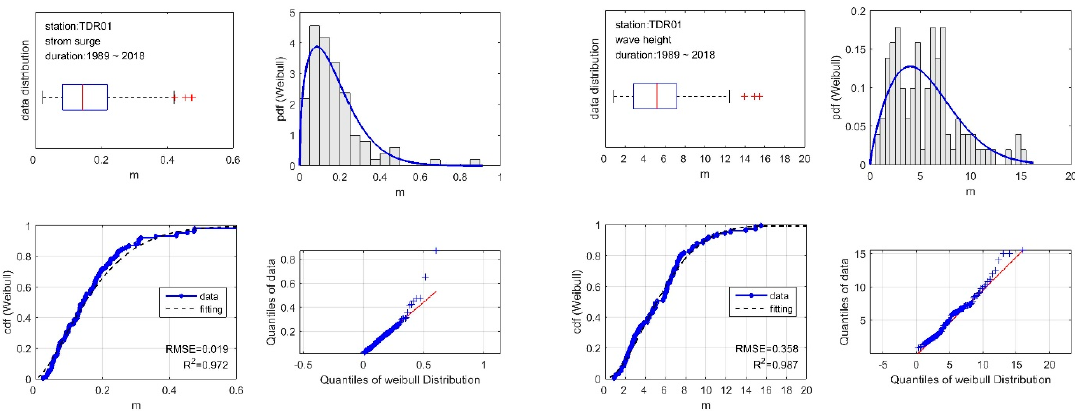
Figure 15. Frequency analysis of the surge heights and wave heights.